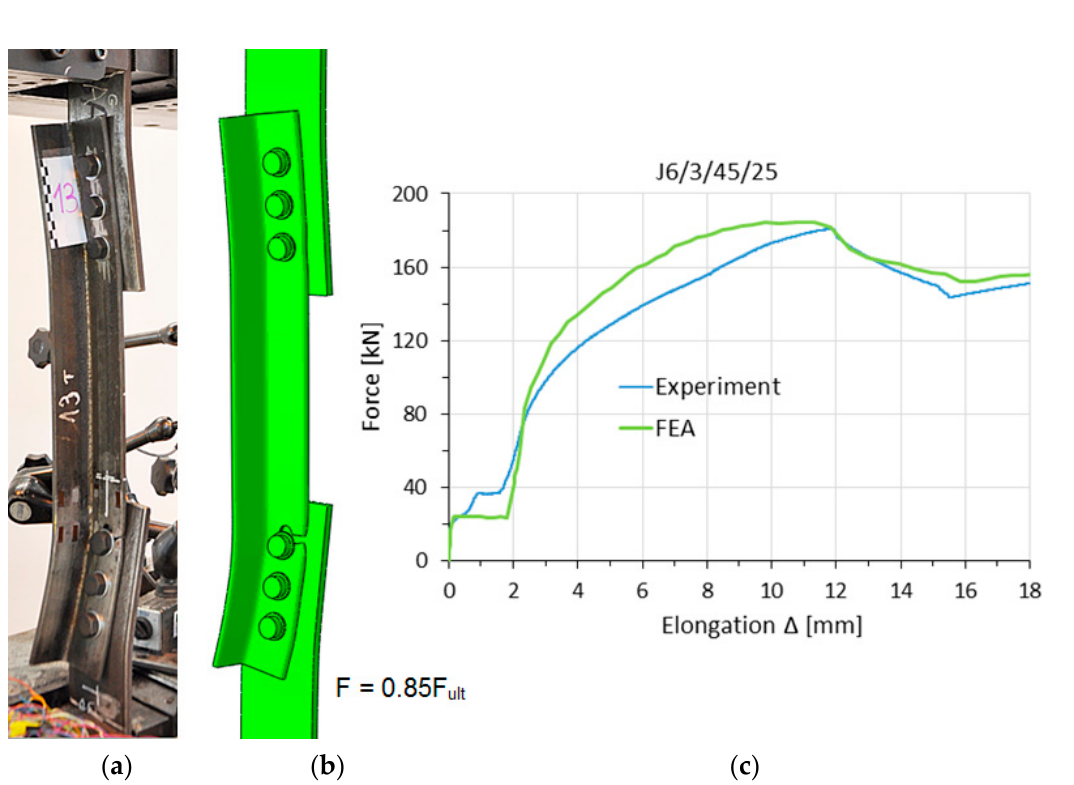
Figure 8. Specimen J6/2/45/25 after fracture: ( a ) experiment, ( b ) FEA model, ( c ) F– Δ curves.